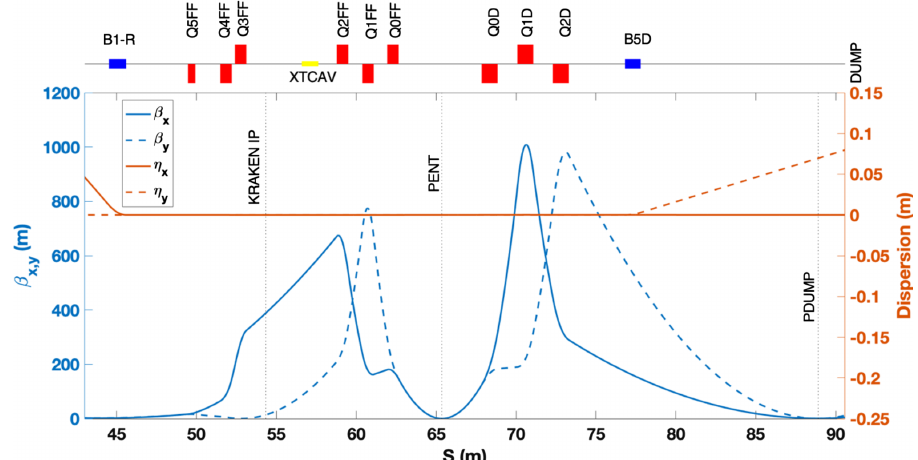
FIG. 2. Beam optical functions in the interaction region with focusing set for PWFA experiments and an imaging condition in the electron beam energy